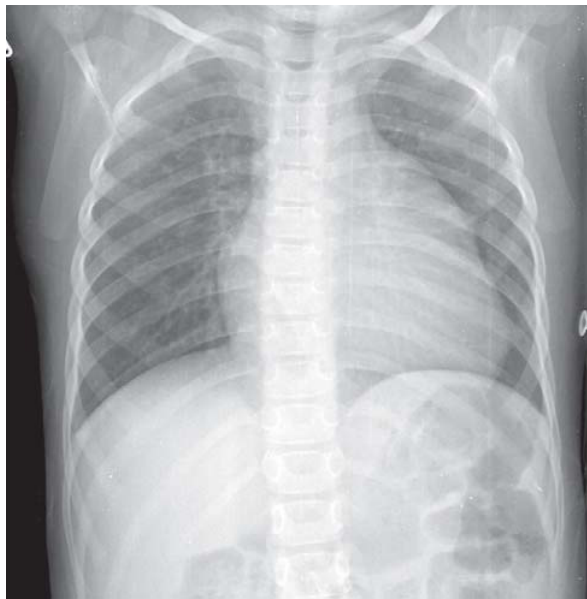
Fig. 2 – Radiografia de tórax pré-operatória com cardiomegalia à custa das cavidades